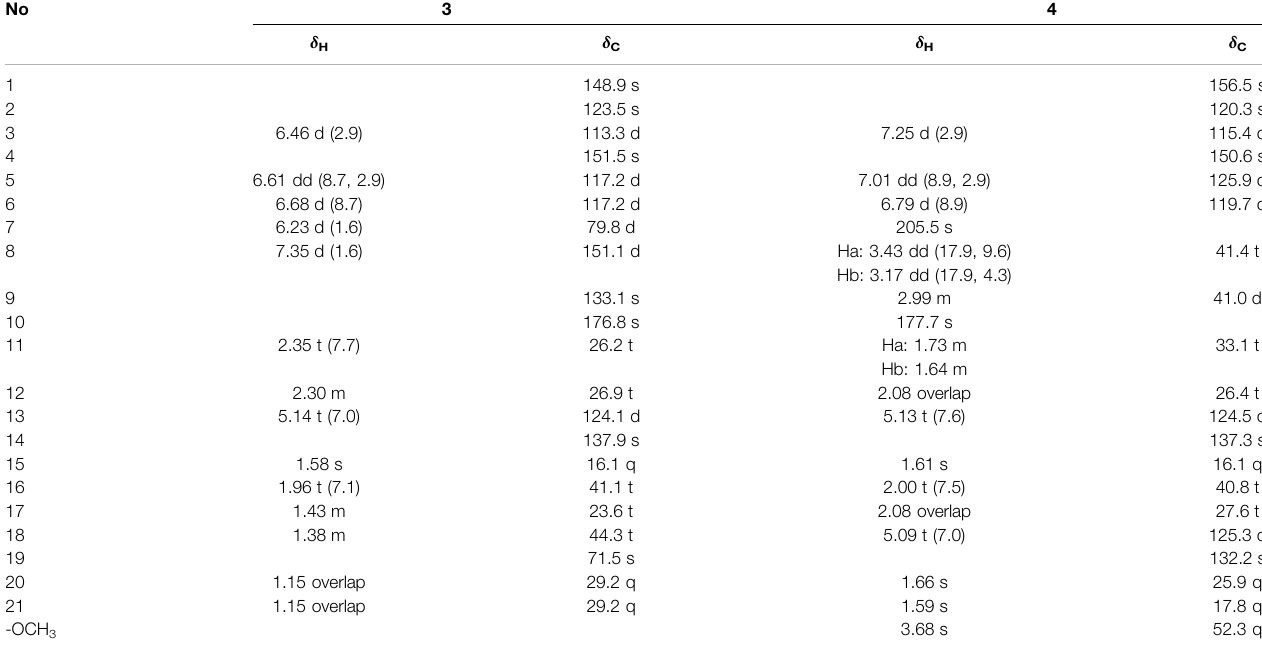
TABLE 2 | 1 H and 13 C NMR data of 3 and 4 in methanol- d 4 ( δ in ppm, J in Hz).